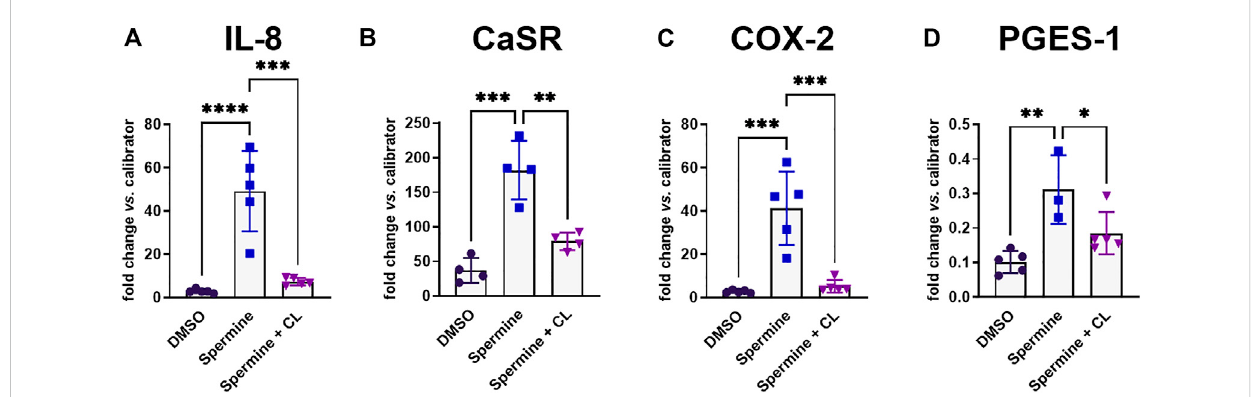
FIGURE 3 Gene induction by spermine can be suppressed by calcilytics. Relative gene expression of (A) IL-8, (B) CaSR, (C) COX-2, and (D) PGES-1 in HT29 CaSR − GFP cells after treatment with 5 mM spermine alone or together with the calcilytic 1 µM NPS 2143 (CL) for 4 h (0.1% DMSO as vehicle control). Mean ± SD, N = 3 – 5, one-way ANOVA with Tukey ’ s post hoc test (0.1% DMSO), * p < 0.05, ** p < 0.01, *** p < 0.001, **** p < 0.0001.